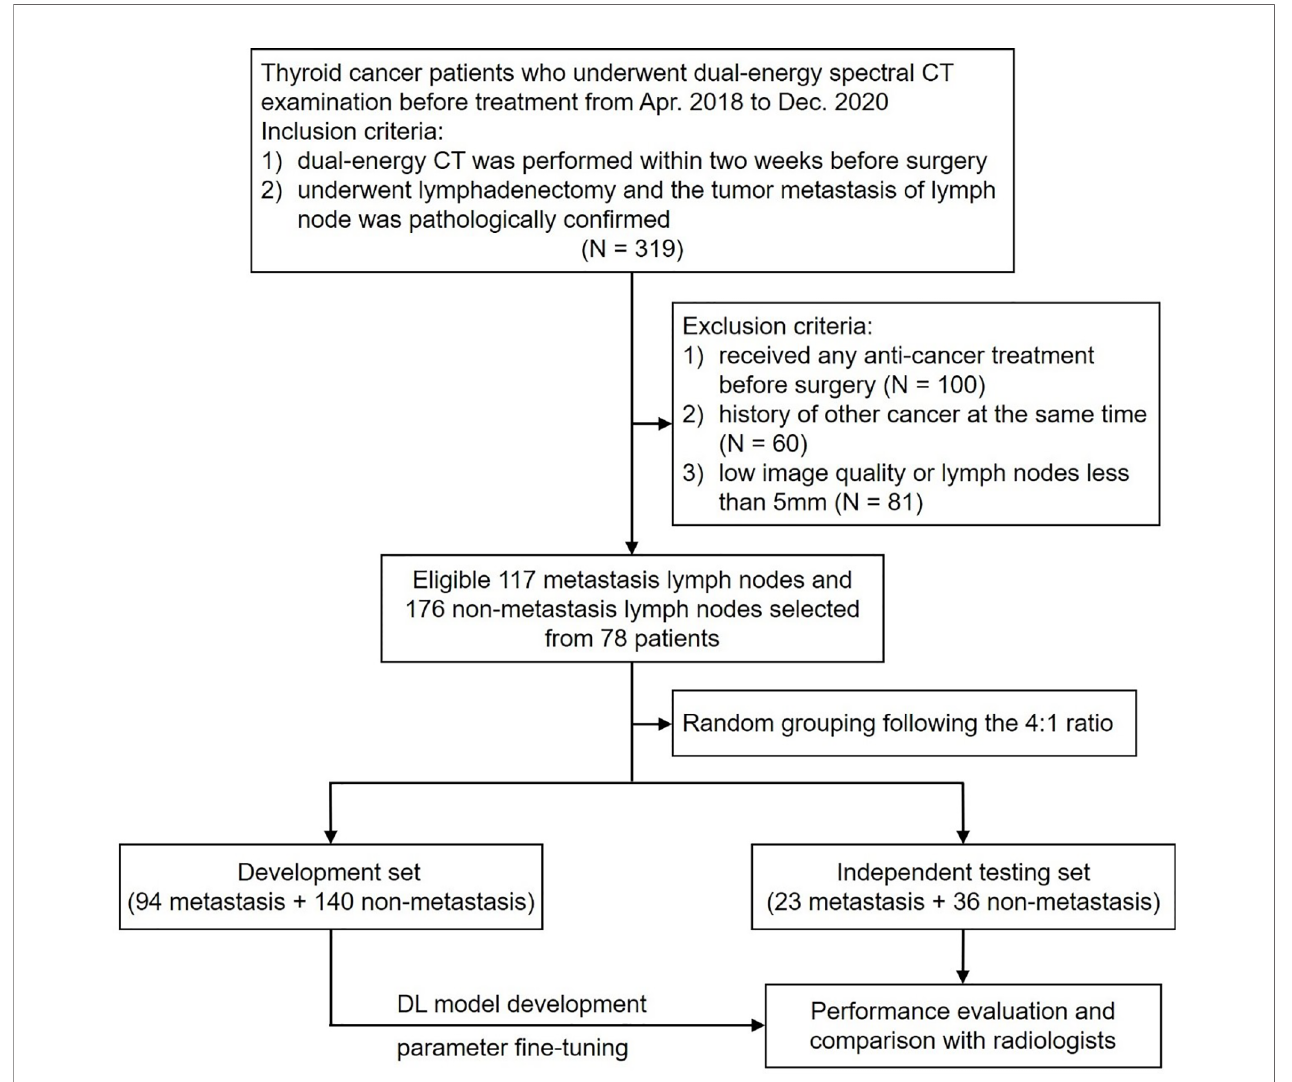
FIGURE 1 | Flowchart of patient enrollment and study